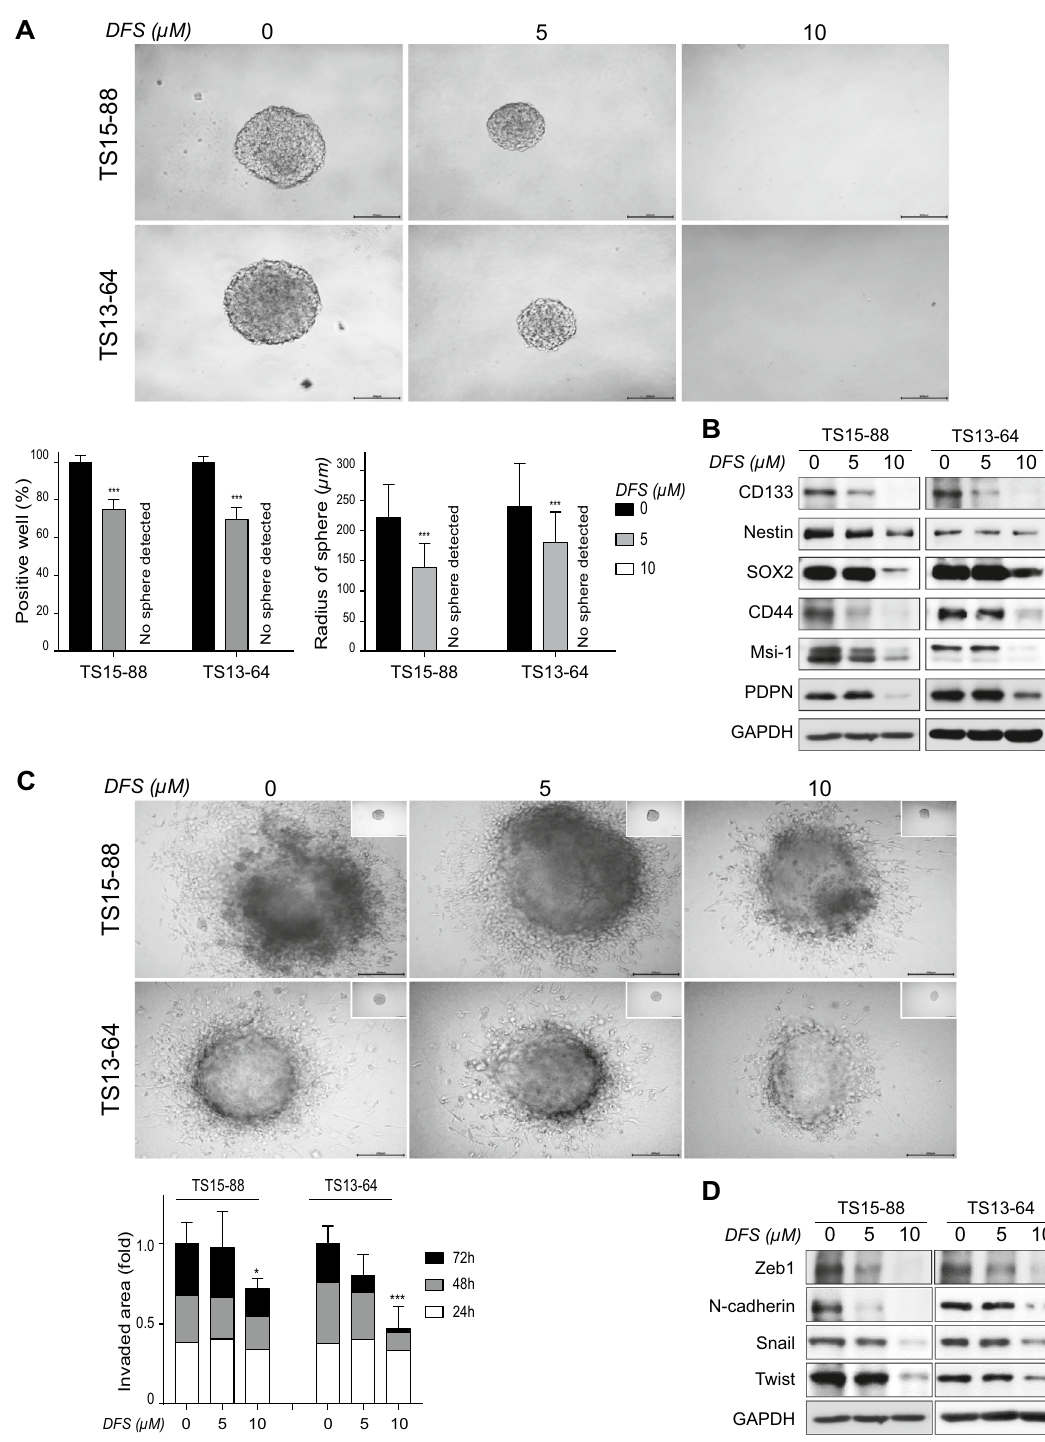
Figure 2. Inhibitory effects of DFS on stemness and invasiveness of GBM TSs. ( A ) Stemness was determined by Sphere formation assay. Cells were treated with DFS for 3 weeks and the percentages of sphere-positive wells and sphere radii were calculated. ( B ) GBM TSs were treated with DFS for 72 h and stemness-associated protein levels were determined by western blotting. ( C ) GBM TSs were cultured on matrigel/collagen matrix with DFS for 72 h, and invasiveness was quantified by measuring areas of migration. ( D ) Western blotting assays of the expression of EMT-related proteins. All Images are × 10 original magnification (scale bar = 200 μm). Differences among groups were compared by one-way ANOVA with Tukey’s post hoc test; means ± SD; *P < 0.05, **P < 0.01, ***P < 0.001, between indicated groups or compared with